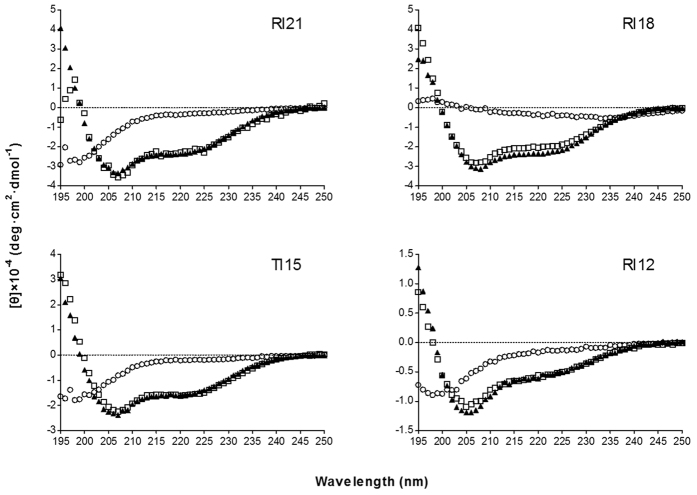
CD spectra of the peptides.The peptides were dissolved in 10 mM sodium phosphate buffer (pH 7.4) (⚪, circles), 50% TFE (▲, triangles), or 30 mM SDS (◻, squares). The mean residue ellipticity was plotted against wavelength. The values from three scans were averaged per sample. The peptide concentrations were fixed at 150 μM.